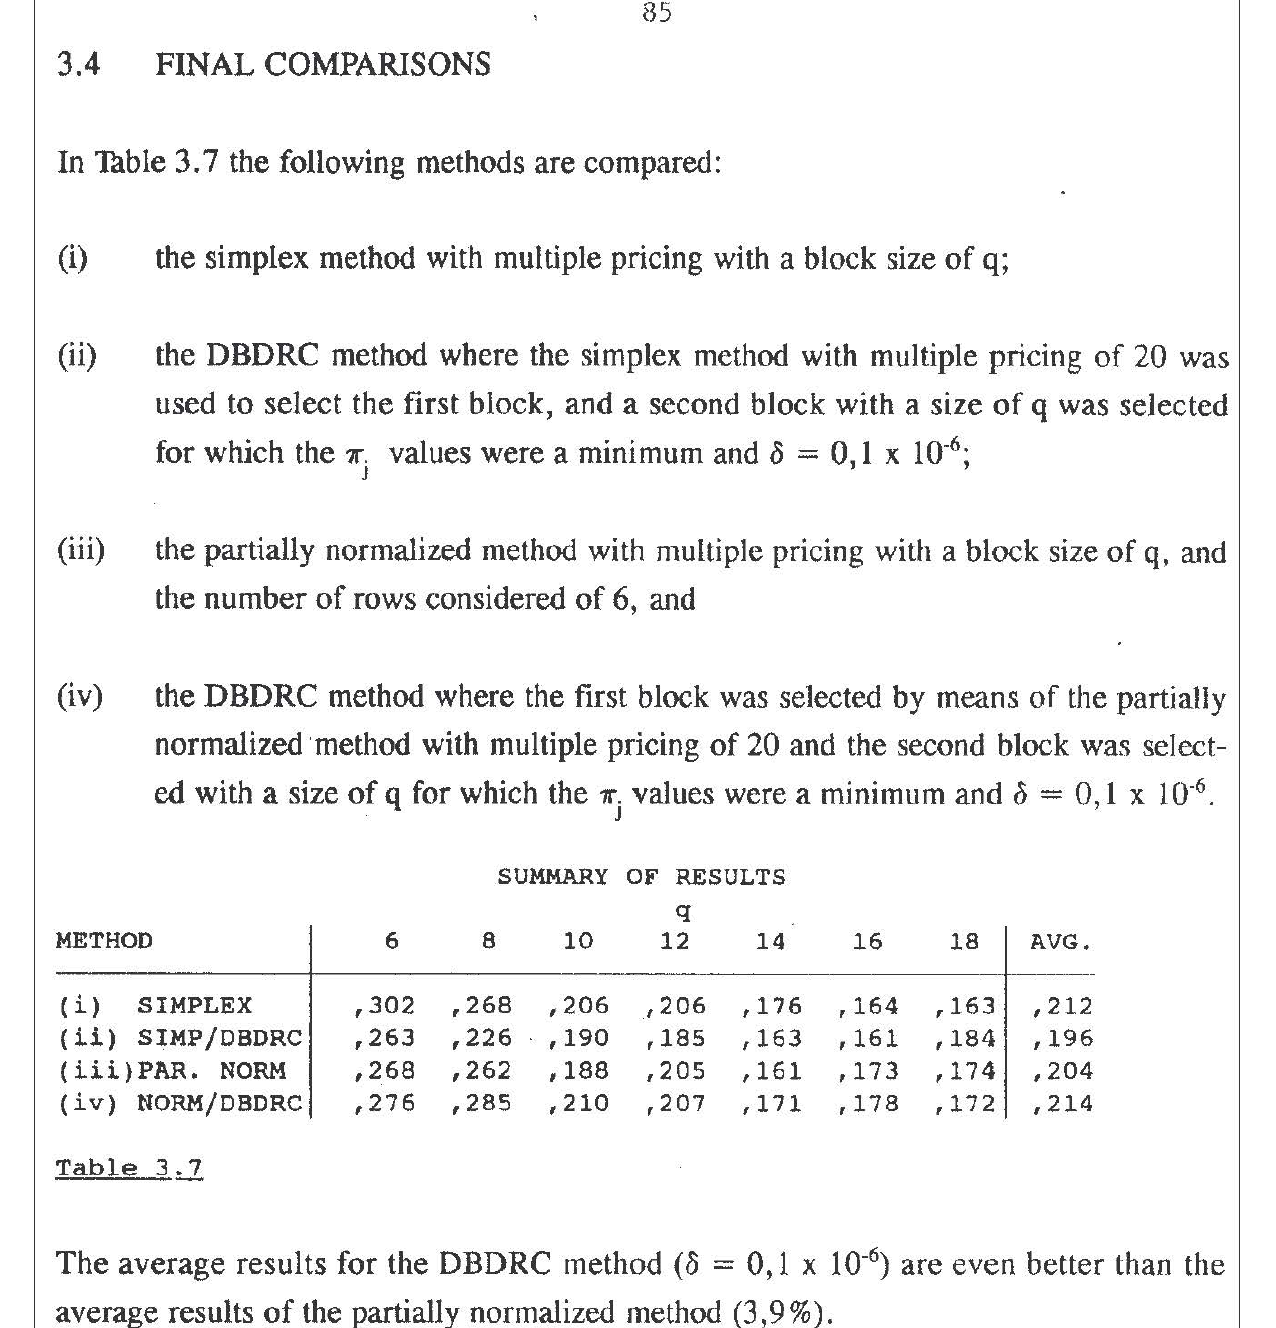
average results of the partially normalized method